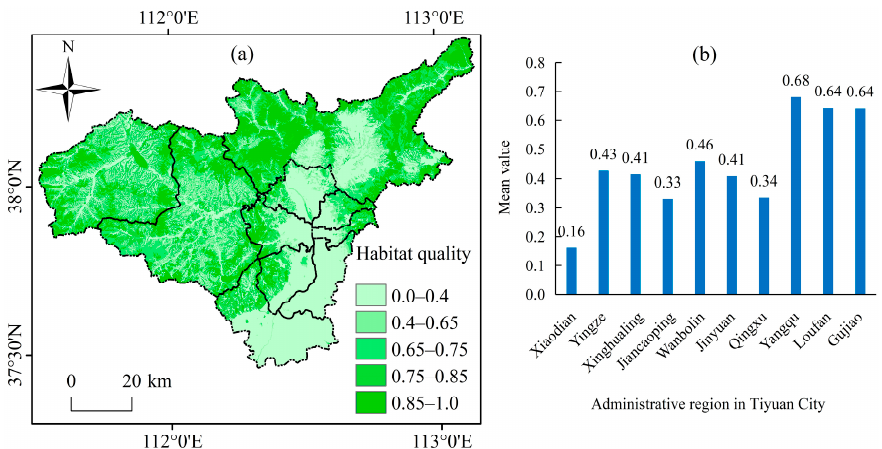
Figure 6. ( a ) Habitat quality assessments. ( b ) Mean habitat quality value in each administrative region.